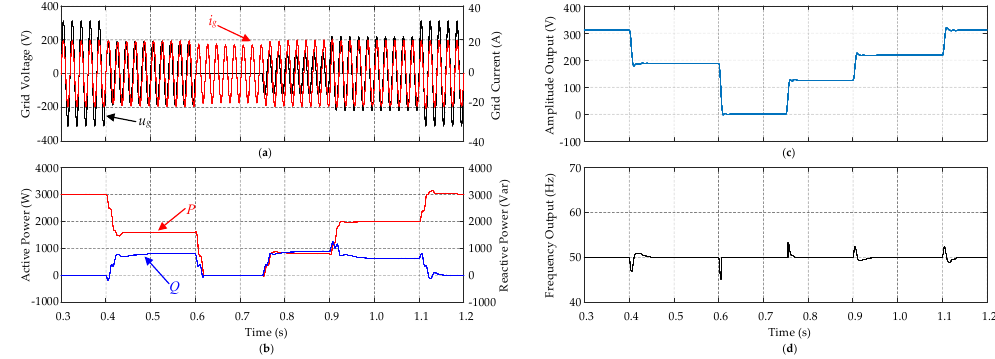
Figure 14. A single-phase PV system under grid voltage fault with modified PLL-based SOGI-OSG: ( a ) grid voltage and current; ( b ) active and reactive power; ( c ) amplitude estimation; ( d ) frequency estimation.